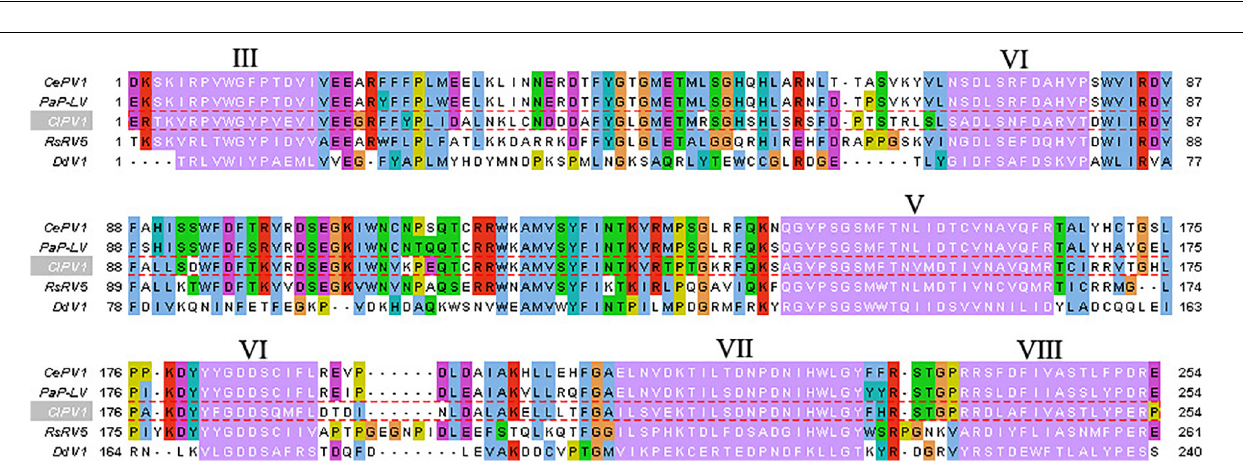
FIGURE 3 | Multiple sequence alignment of the aa sequences of the RdRp encoded by ClPV1. Conserved motifs III–VIII were showed by Roman numerals. The abbreviations of virus names are as follows: CePV1, Colletotrichum eremochloae partitivirus 1 (AZT88590.1); PaP-LV, Penicillium aurantiogriseum partiti-like virus (YP_009182157.1); RsPV5, Rhizoctonia solani dsRNA virus 5 (AVP26802.1); and DdV1, Discula destructiva virus 1 (NP_116716.1).